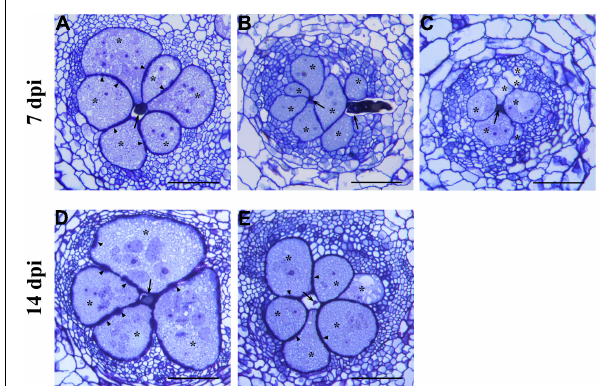
FIGURE 1 | Histological analysis of giant cells (GCs) induced by Meloidogyne incognita in normally watered (RKN) and water-stressed (RKN_WS) tomato roots at 7- and 14-day post inoculation (dpi). Cross sections (2.5 µ m) were stained with toluidine blue and observed at light microscope. (A) Well developed and metabolically active giant cells in RKN roots at 7 dpi. (B,C) Feeding sites in RKN_WS galls at 7 dpi. (B) GCs look similar to those in unstressed gall but are smaller in size. (C) GCs contain large vacuoles and cytoplasm poorly active showing a delay in their development. Cell walls in all RKN_WS feeding sites at 7 dpi are thinner than those in RKN galls. (D) GCs in RKN galls at 14 dpi show a large expansion with increase in cell wall thickness and density of cytoplasm. (E) GCs in RKN_WS galls at 14 dpi look significantly smaller but similar in appearance to GCs in unstressed galls. *, GCs; arrow, nematode; arrowhead, thickened cell walls; scale bar, 100 µ